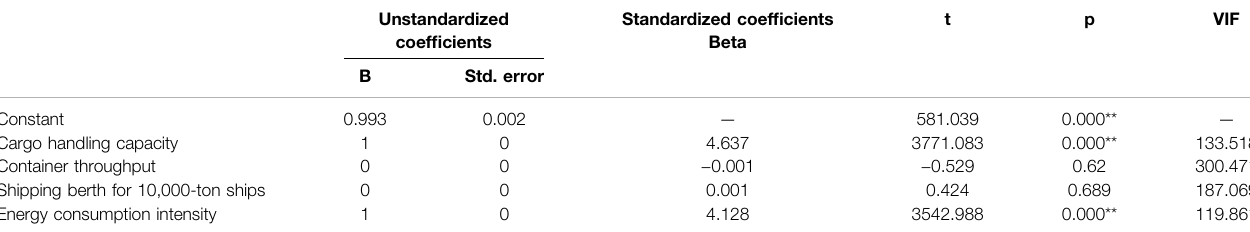
TABLE 2 | The results of parameter estimates.